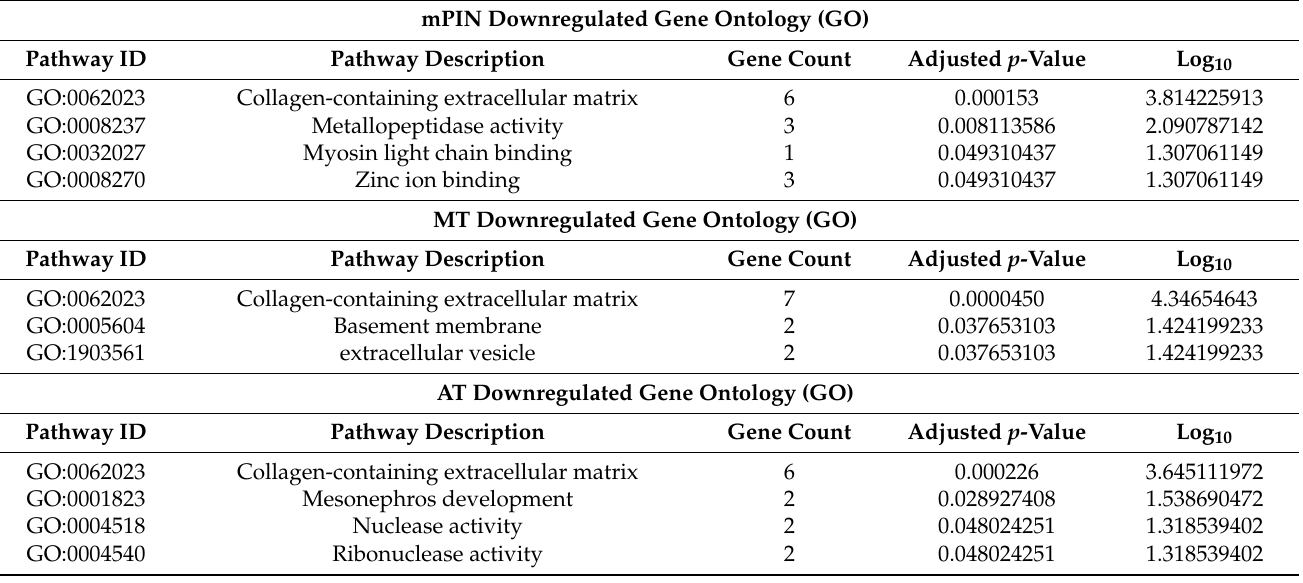
Table 4. A gene ontology (GO) enrichment analysis of secreted proteins downregulated in mPIN, MT and AT of prostate